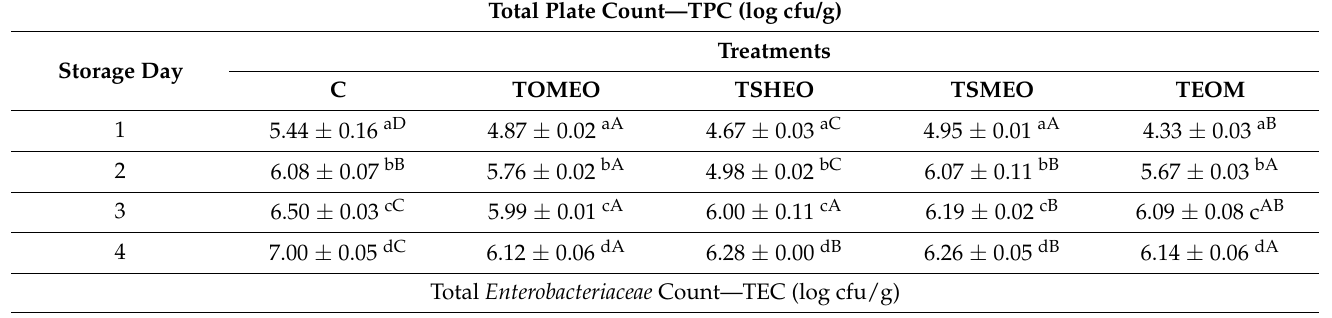
Table 4. Microbiological profile of fresh turkey